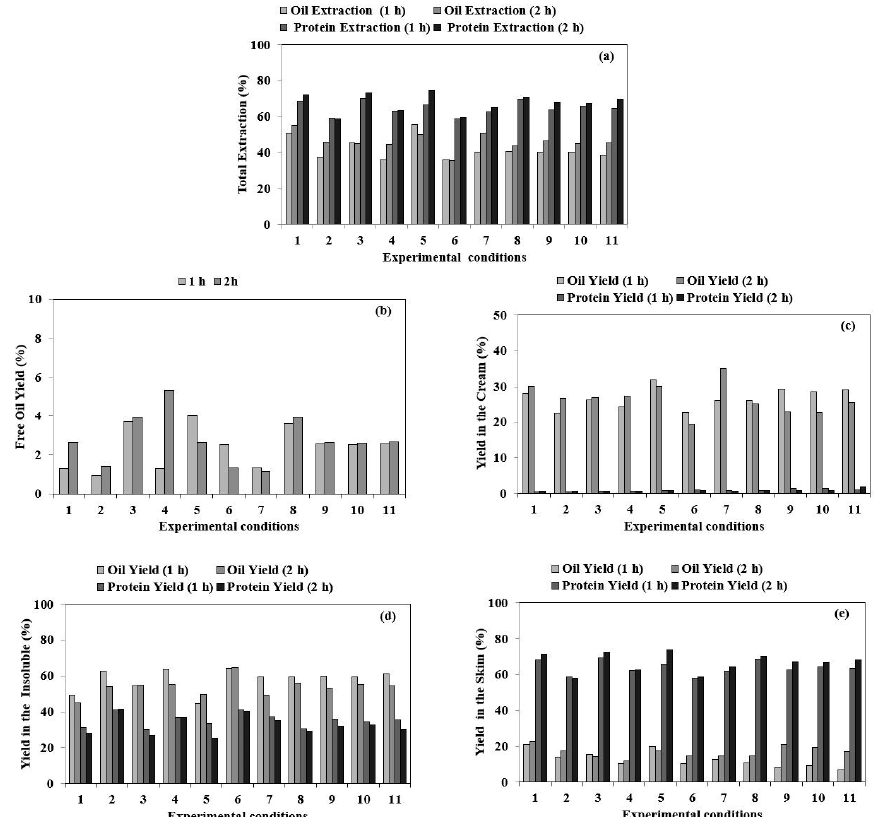
Figure 3. Effects of solids-to-liquid ratio (SLR) and amount of enzyme on extraction yields and distribution of oil and protein among the fractions generated by the EAEP at 1 and 2 h: ( a ) Total oil and protein extraction yields (%); ( b ) free oil yield (%); ( c ) oil and protein yield in the cream (%); ( d ) oil and protein yield in the insoluble (%); ( e ) oil and protein yield in the skim (%). Experimental conditions: 1 (1:12 SLR and 0.25% enzyme (wt / wt*)); 2 (1:8 SLR, 0.25% enzyme (wt / wt)); 3 (1:12 SLR, 0.75% enzyme (wt / wt)); 4 (1:8 SLR, 0.75% enzyme (wt / wt)); 5 (1:12.82 SLR, 0.50% enzyme (wt / wt)); 6 (1:7.18 SLR, 0.50% enzyme (wt / wt)); 7 (1:10 SLR, 0.15% enzyme (wt / wt)); 8 (1:10 SLR, 0.85% enzyme (wt / wt)); 9, 10, and 11 (1:10 SLR, 0.50% enzyme (wt / wt). *(wt / wt, weight of enzyme / weight of almond